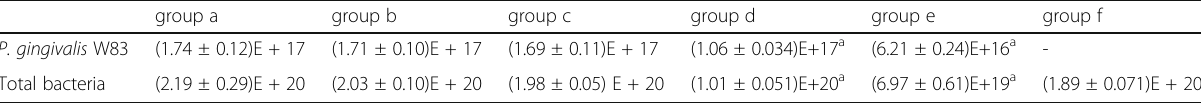
Table 1 DNA copy numbers of P. gingivalis W83 and total bacteria loads